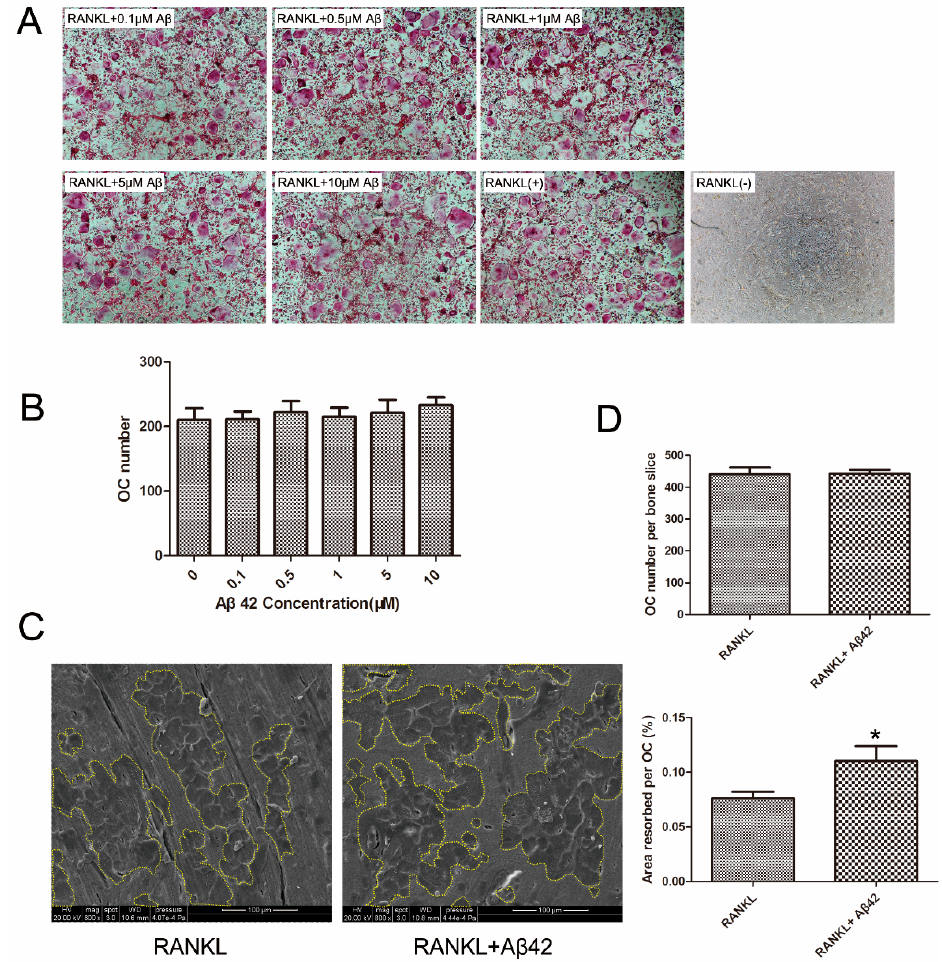
Figure 1. A β 42 has no effect on RANKL-induced osteoclastogenesis but enhances osteoclast (OC) function. ( A ) Light microscopy images depicting the effect of various concentrations (0.1, 0.5, 1, 5, 10 μ M) of A β 42 on RANKL-induced OC formation at 40× magnification positively stained with tartrate resistant acid phosphatase (TRAP). TRAP positive cells containing three or more nuclei were counted as OCs; ( B ) Quantification of mature OC showing no statistical difference among cells treated with different concentrations of A β 42; ( C ) Representative scanning electron microscopy (SEM) images of resorption area in bone slices showing A β 42 enhanced RANKL-induced bone resorption by OCs; ( D ) Quantification analysis showing A β 42 enhanced OC activation by increasing resorption area (~1.6-fold change). Bar in C represents 100 µ m. Experiments were carried out in triplicate and results are presented as mean ± SD. * p < 0.05.